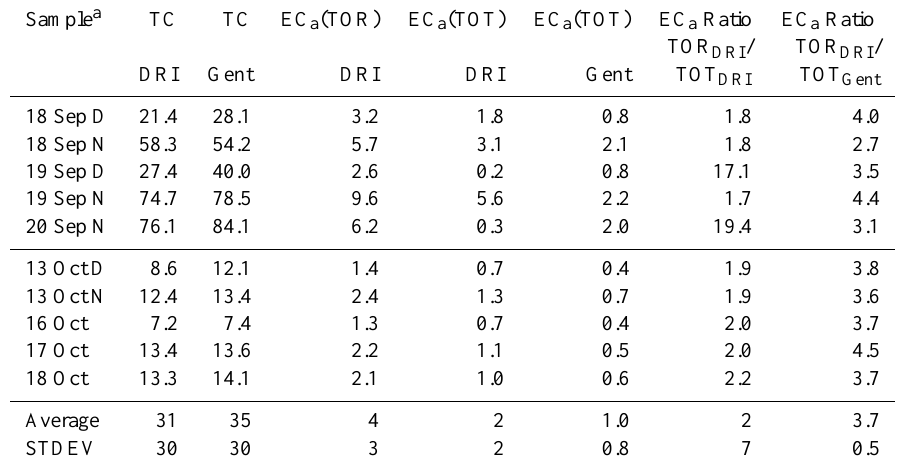
Table 3. Comparison of TC and EC a measurements by two different laboratories (University of Gent (Gent) and Desert Research Institute (DRI)) using the TOT and TOR techniques. All concentrations are given in µgm − 3 . Sample a TC TC EC a